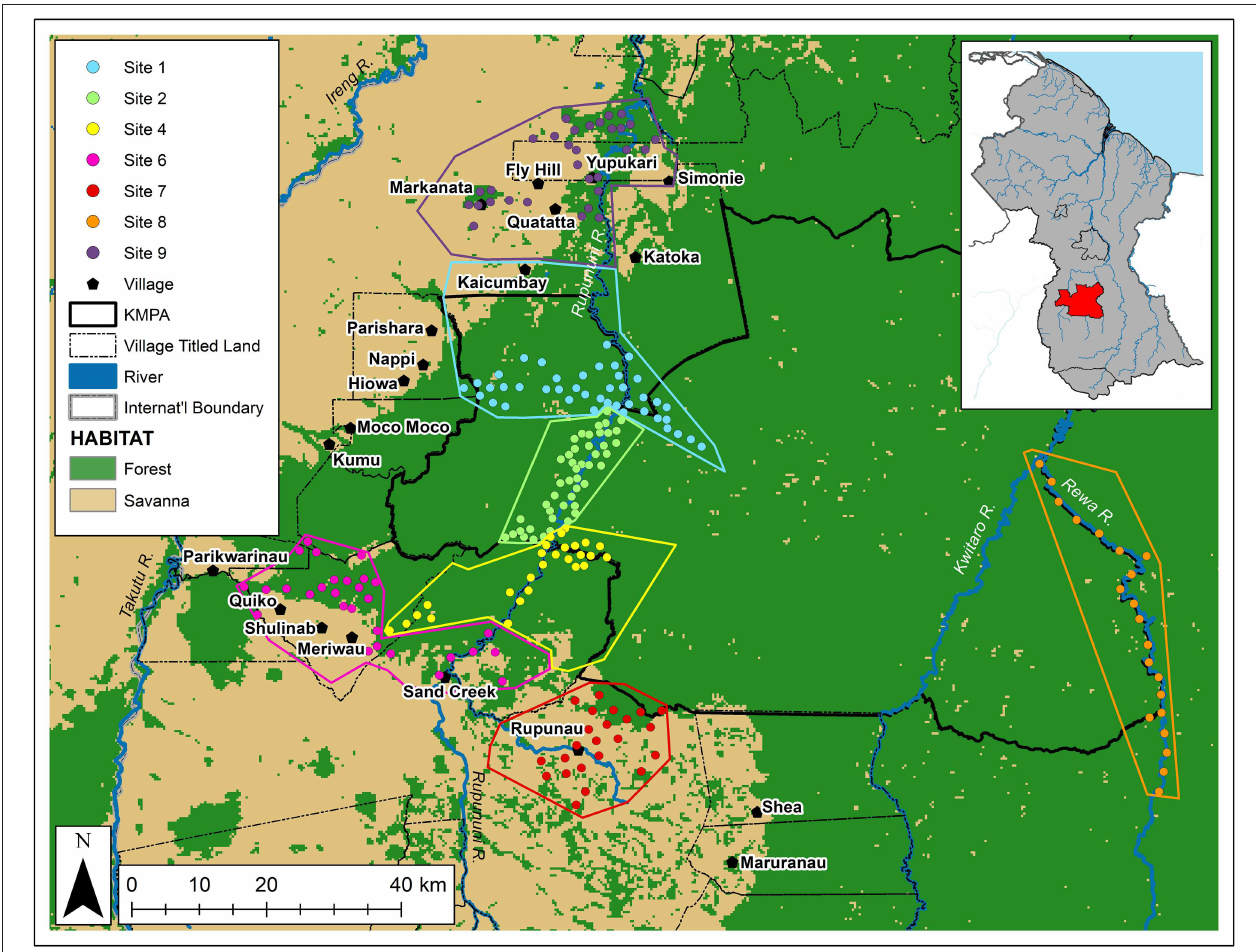
FIGURE 1 | Map of the Kanuku Mountains region, showing camera-trap locations (circles), hunting sites (polygons), and villages (pentagons), as well as the boundaries of the KMPA (solid line) and indigenous community titled lands (dotted line) ( Arino et al., 2012; Environmental Systems Research Institute (ESRI),